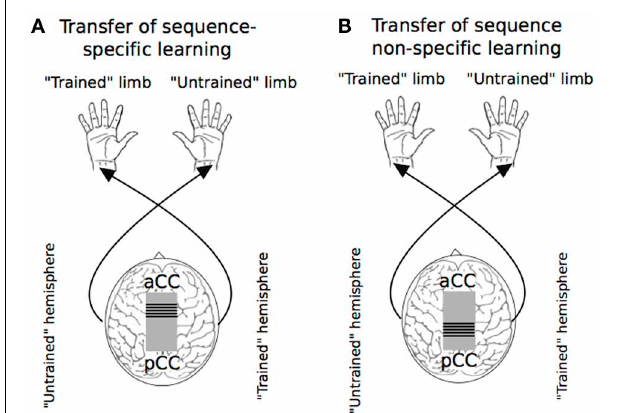
FIGURE 6 | Callosal pathways mediating the transfer of sequence specific and sequence non-specific learning in the Serial Reaction Time Task. “aCC” and “pCC” define the anterior-posterior axis of the corpus callosum. Panel (A) illustrates that the transfer of sequence-specific aspects of the SRTT occurs primarily via interhemispheric fibers in the anterior midbody of the corpus callosum. Panel (B) indicates that the transfer of non sequence-specificlearning is predominantly via fibers in the posterior midbody of the corpus